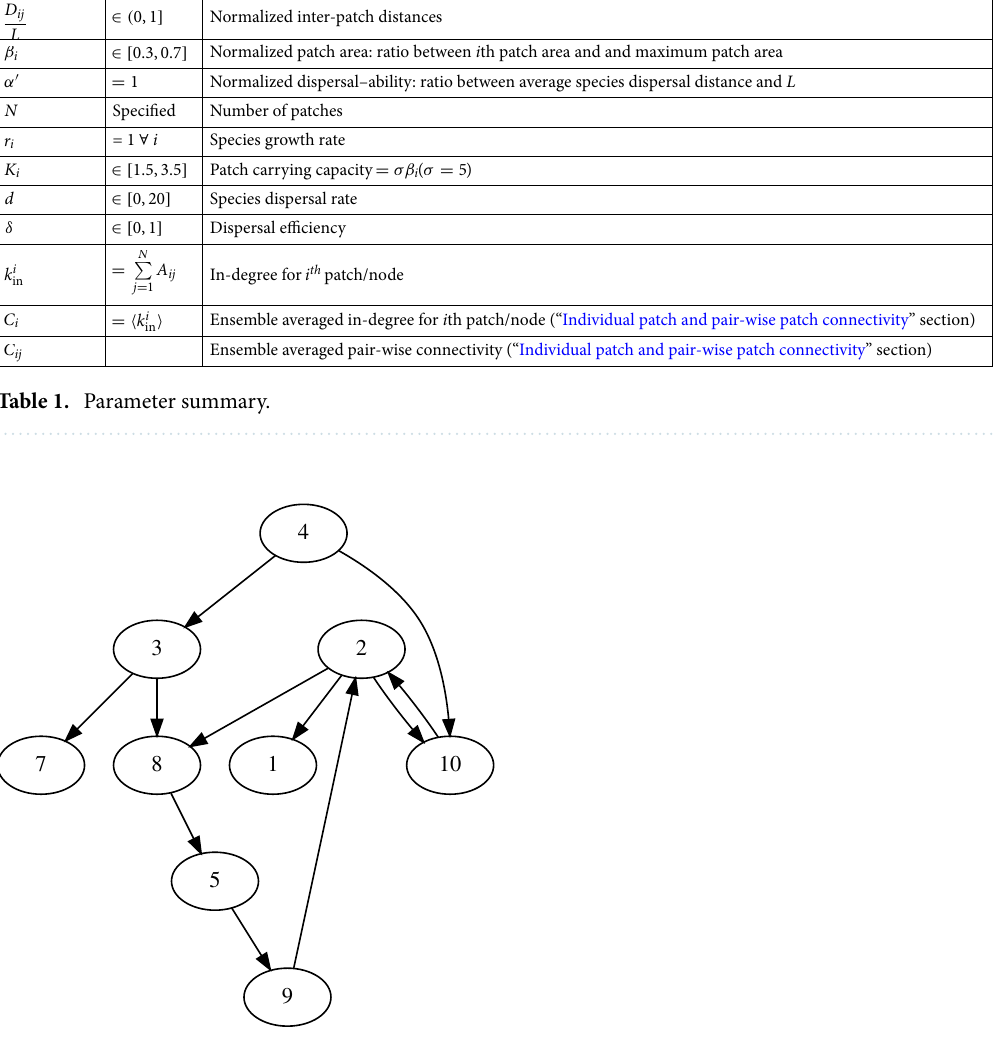
Figure 1. Schematic realization of an NPC consisting of 10 nodes. Connectivity estimated using identical patch 0.55 i and an arbitrary underlying landscape with random, normalized inter-patch distances areas β i = ∀ D ij ( 0, 1 i , j ] ∀ L ∈